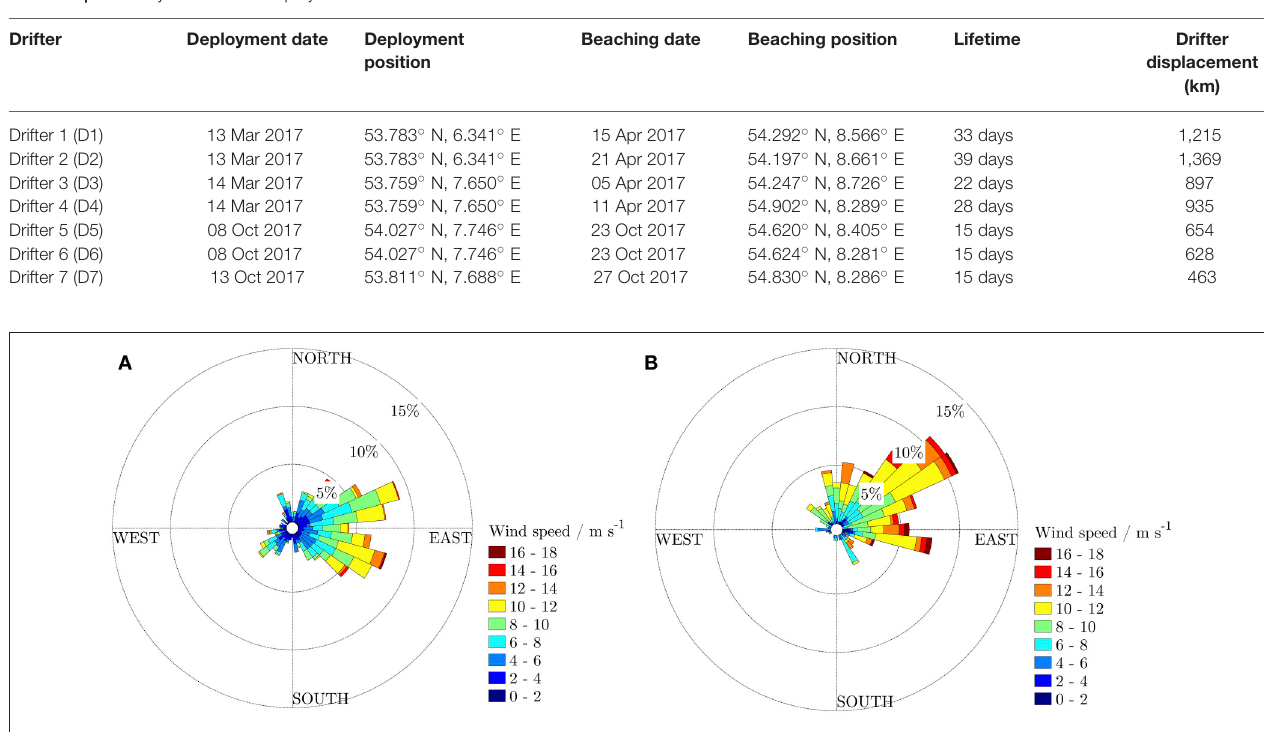
FIGURE 5 | Distribution of wind speed and direction measured at the DWD weather station in Heligoland during the March 2017 drifter deployments (A) and for the October 2017 drifter deployment (B) . The wind direction is displayed in the direction of the blowing wind and the color code refers to the wind speed in ms − 1 .